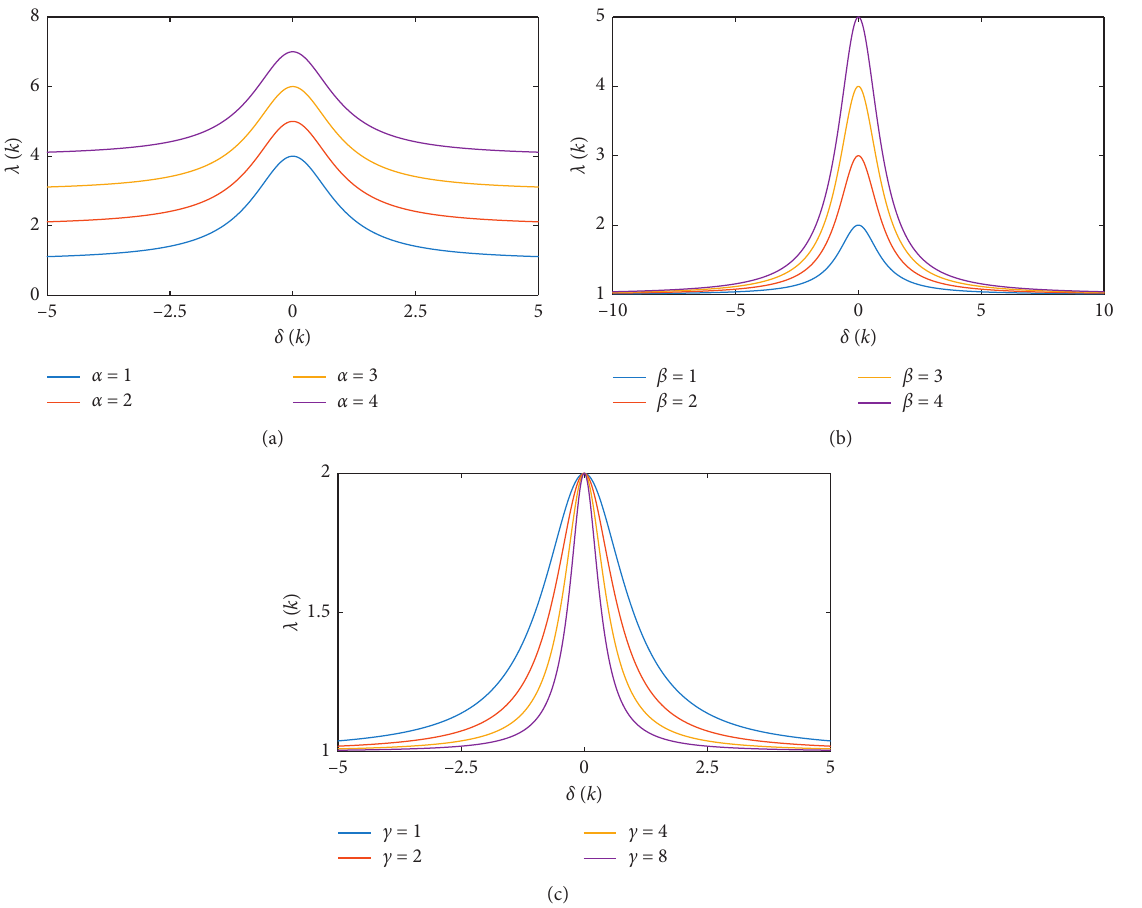
Figure 9: (a) The influence of parameter α on λ ( k ). (b) The influence of parameter β on λ ( k ). (c) The influence of parameter c on λ ( k ).